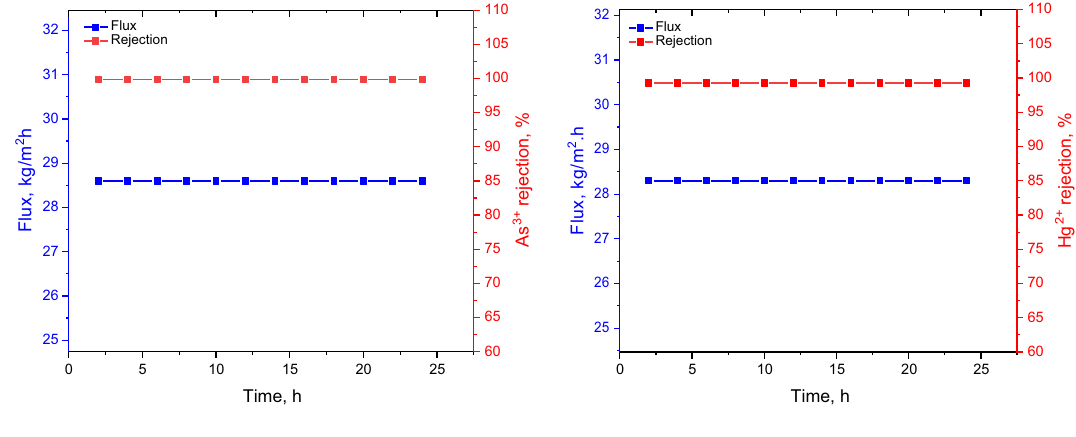
Fig. 11 The rejection and permeation flux of M5 versus time for a As 3+ and b Hg